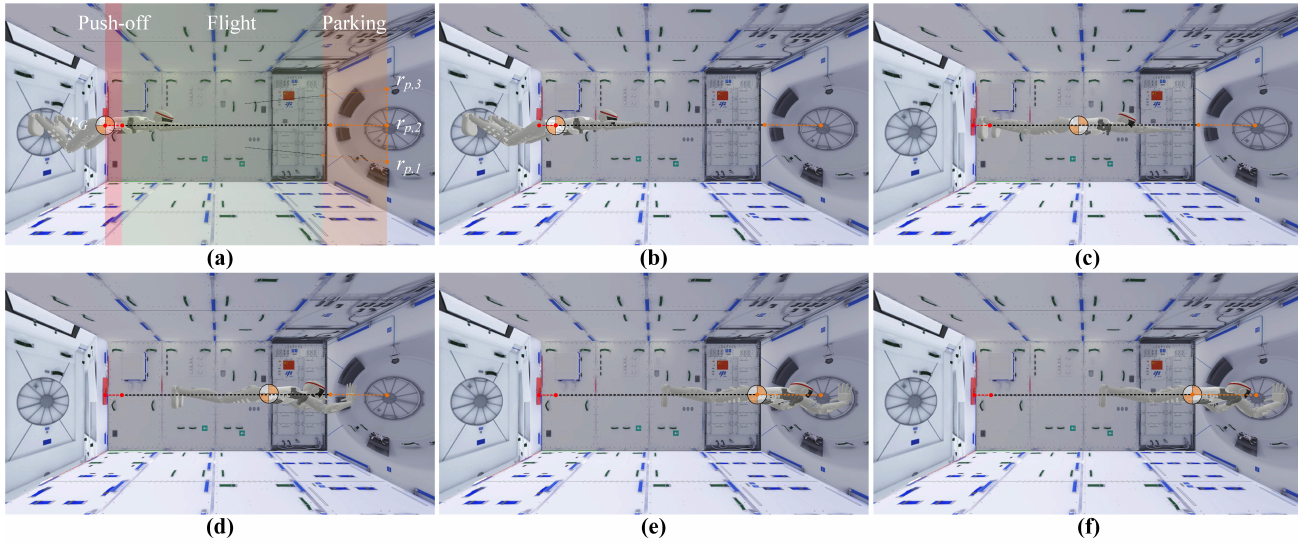
Figure 5. The PFP locomotion in microgravity during ( a , b ) the push-off phase, ( c , d ) the flight or free-flying phase, and ( e , f ) the parking